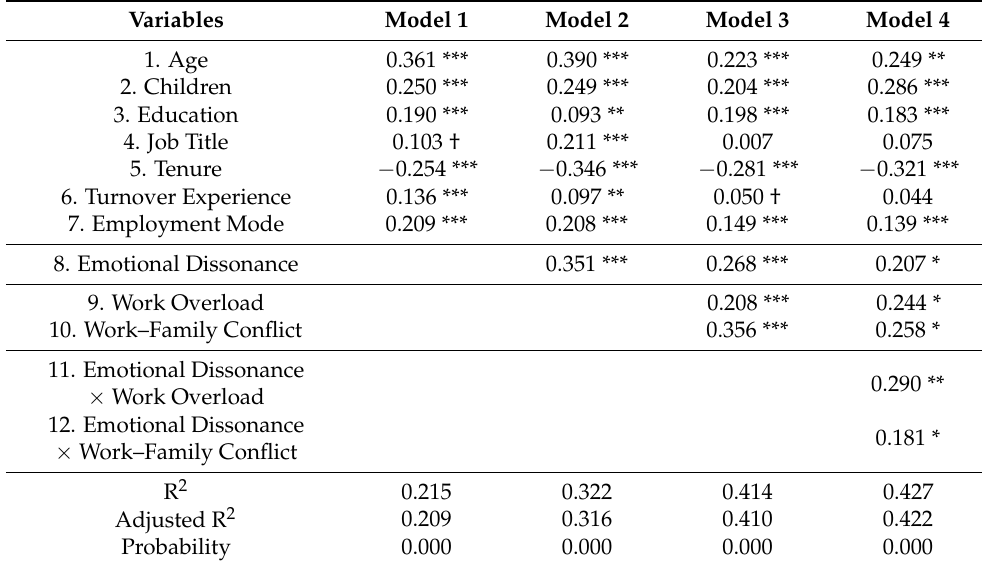
Table 3. The regression results of emotional dissonance on job